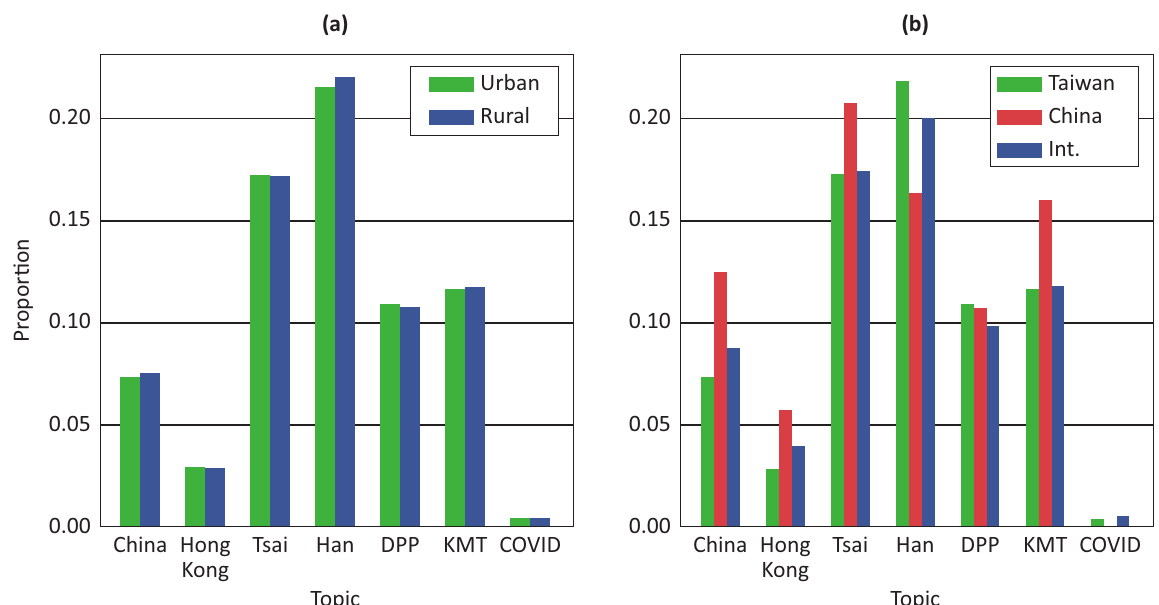
Figure 4. Level of disagreement across different user groups based on IP address: (a) across the urban-rural divide; (b) between users from Taiwan, China, and other international locations.